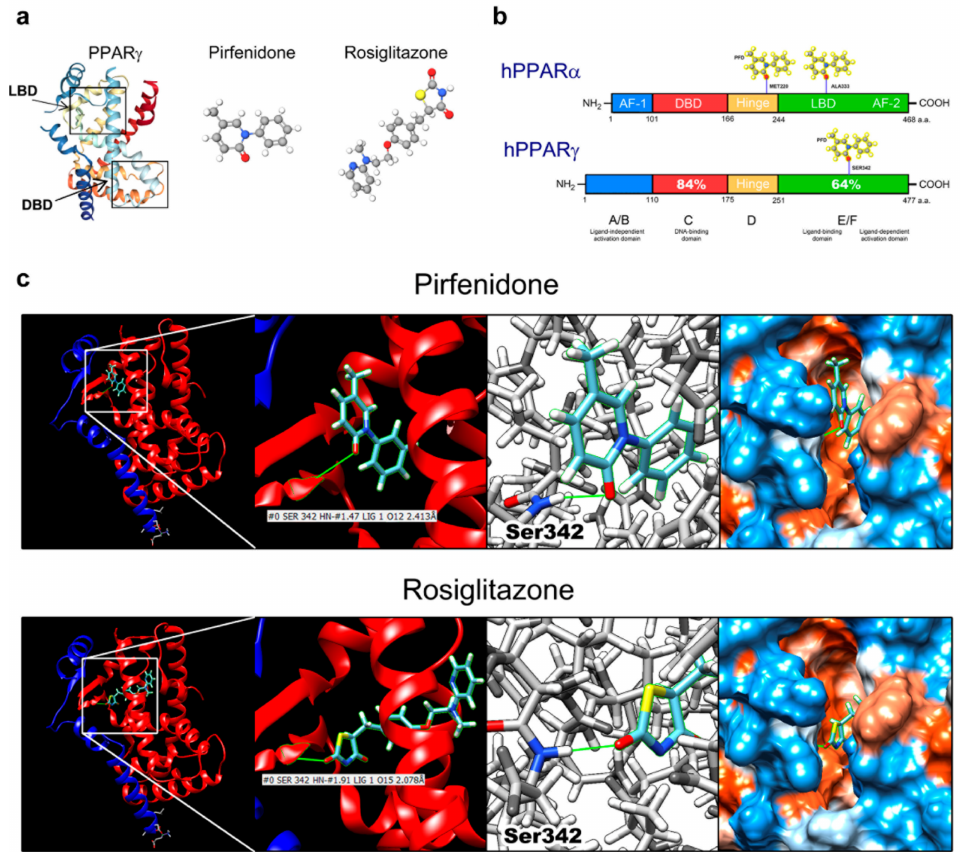
Figure 7. Pirfenidone is a ligand/agonist for PPAR γ . ( a ) Representative images of PPAR γ with LBD obtained from PDB. ( b ) Linear image of PPAR α and PPAR γ showing the homology between these proteins and probable PFD binding sites. Percentage of 64% homology in LBD between proteins is shown. ( c ) In silico assay with PFD and rosiglitazone with PPAR γ LBD. LBD: ligand-binding domain; DBD: DNA-binding